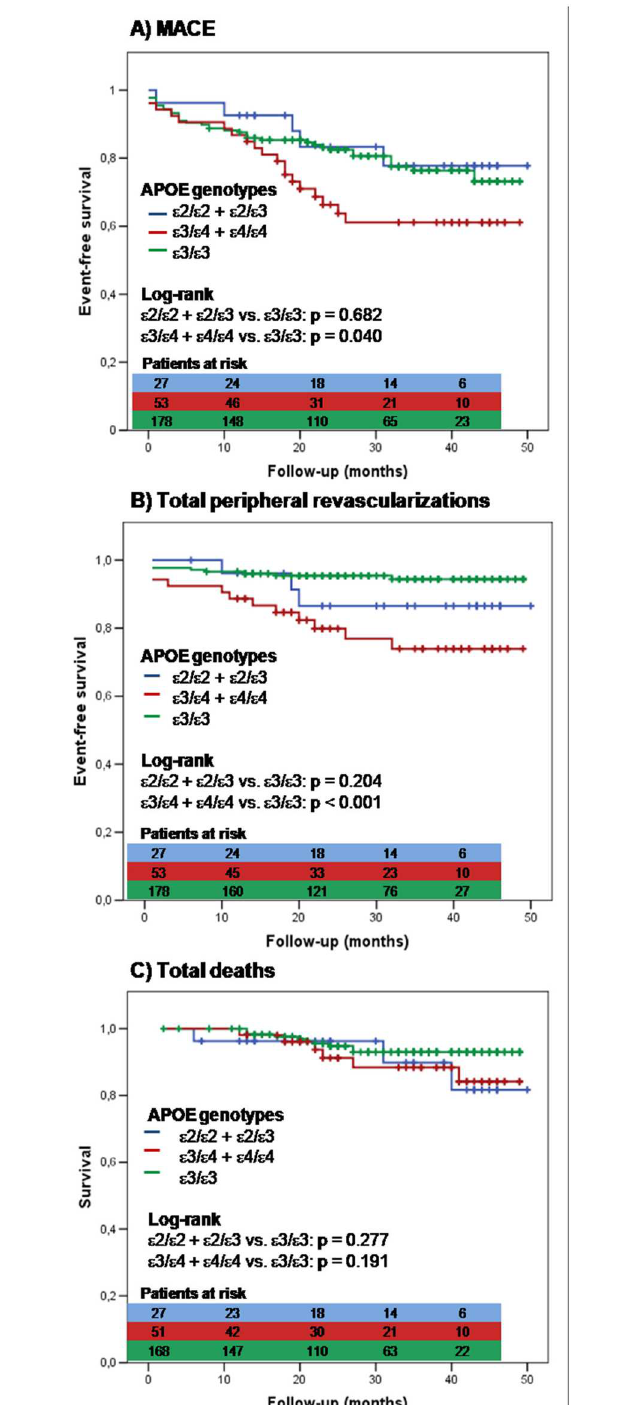
Fig 2. Kaplan–Meier estimatesof the adverseevents according to genotype. A) Major adversecardiac events (MACE), B) Total peripheral revascularizations, C) Total deaths.